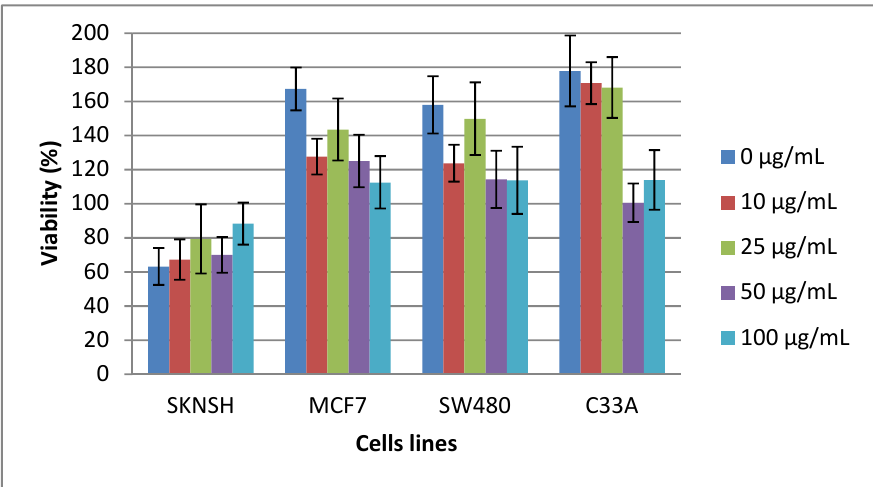
cells, employing the 3-(4,5-dimethylthiazol-2-yl)-2,5-diphenyltetrazolium bromide (MTT) cell assay. The cells were previously incubated for 24 h with the lectin solution. Then, the solution was removed and the cells were incubated for only 48 h with the cell culture solution [Dulbecco’s modified Eagle’s medium (DMEM) and fetal bovine serum (FBS)]. All values are expressed as mean ± SEM of three independent experiments.